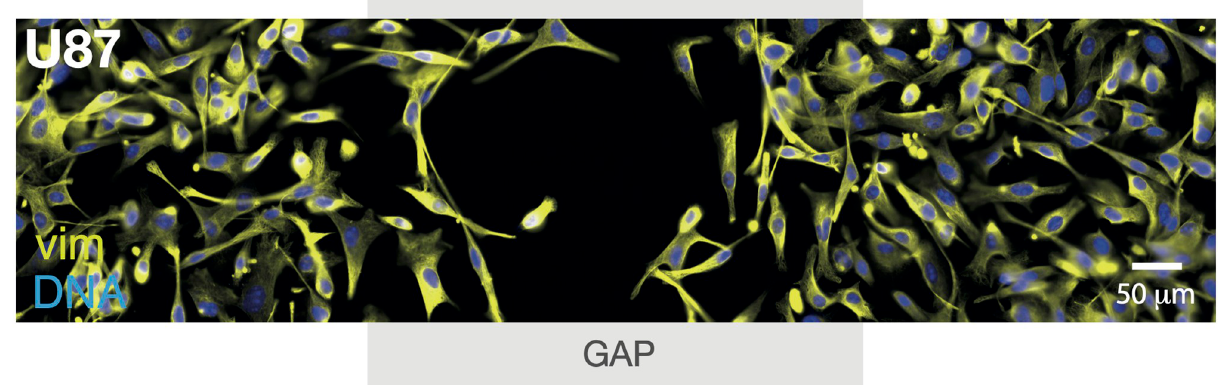
Fig 2. Spatial patterns of vim marker in 2D. Wound healing experiment in surface-attached U87 brain cancer cells, where the original wound is indicated by the light grey area (GAP). Immunofluorescence parallel assays after 24 hours growth of vim (yellow) and cell nuclei identified by a nuclear stain (blue).